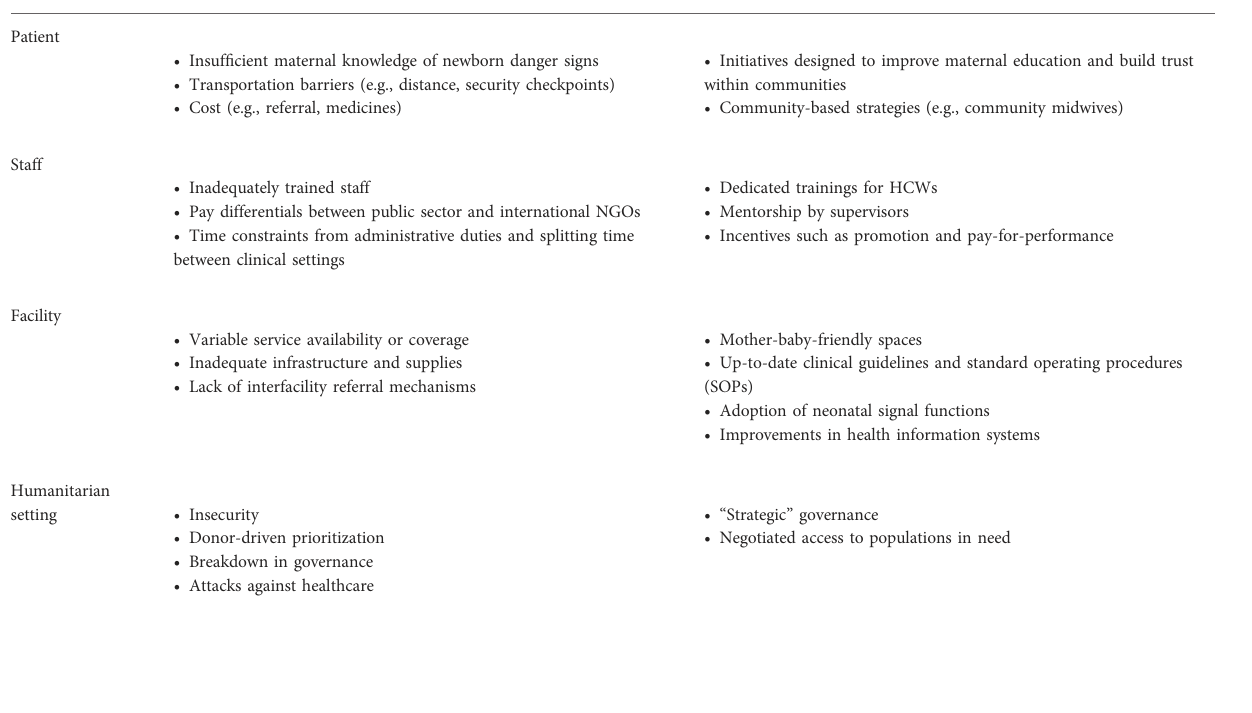
TABLE 3 Barriers to ENC delivery and strategies for improvement, by level. Level